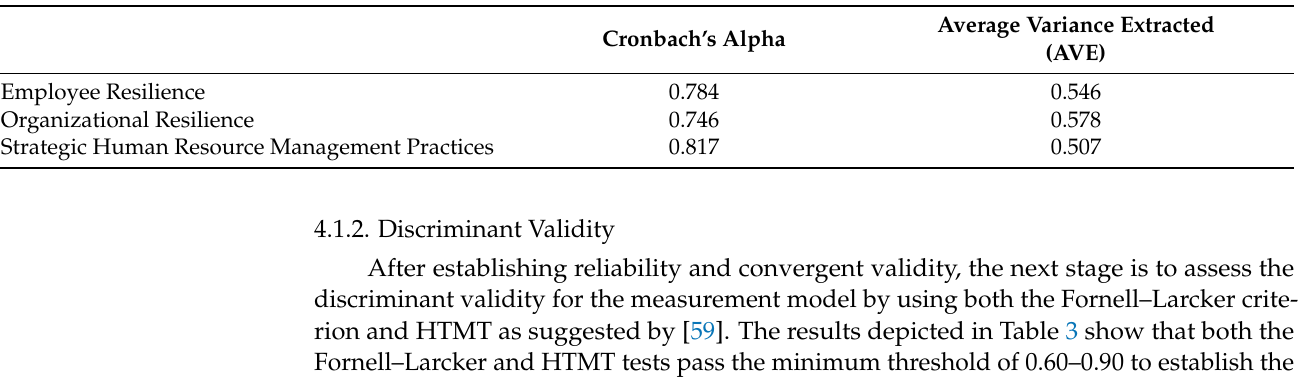
Table 2. Construct reliability and validity.